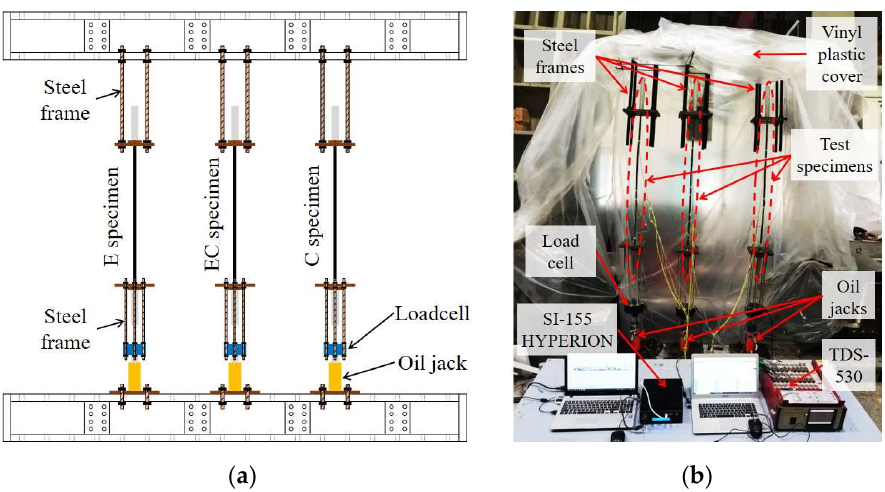
Figure 9. The short-term tensile test setup: ( a ) Setup schema; ( b ) Picture of the test setup.